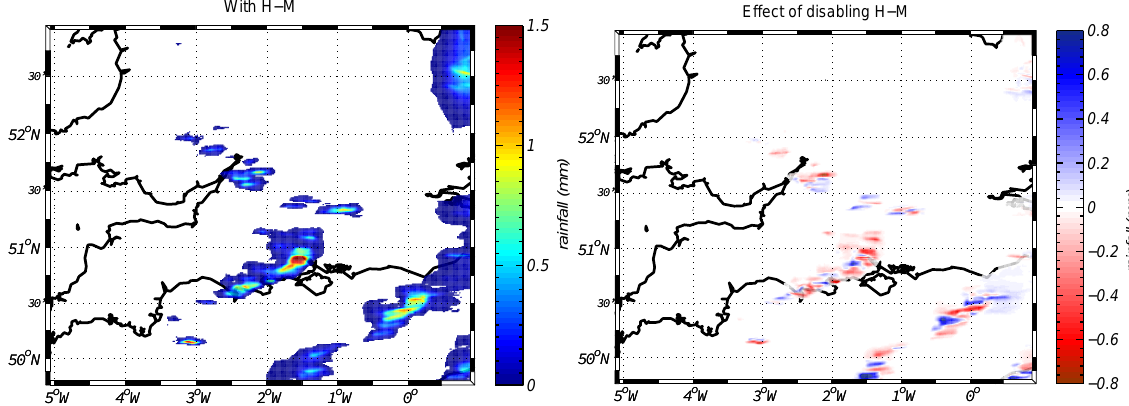
Fig. 11: Surface precipitation accumulated between 14:10 UTC and 14:30 UTC for: WRF with HM (left); Difference caused Fig. 11. Surface precipitation accumulated between 14:10UTC and 14:30UTC for: WRF with HM (left); Difference caused by disabling by disabling HM (right). HM (right).